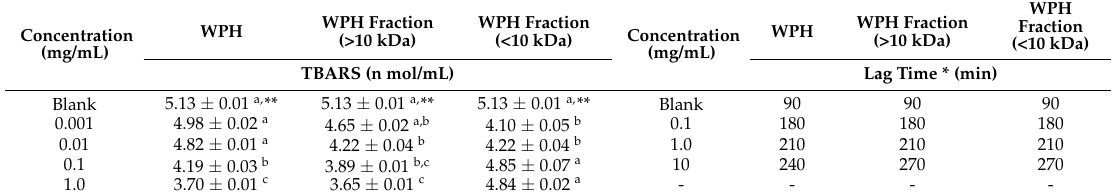
Table 3. Effects of WPH and WPH fractions on the formation of thiobarbituric acid reactive substances (TBARS) and conjugated dienes on low-density lipoprotein (LDL) oxidation induced by Cu 2+ . Concentration (mg/mL)